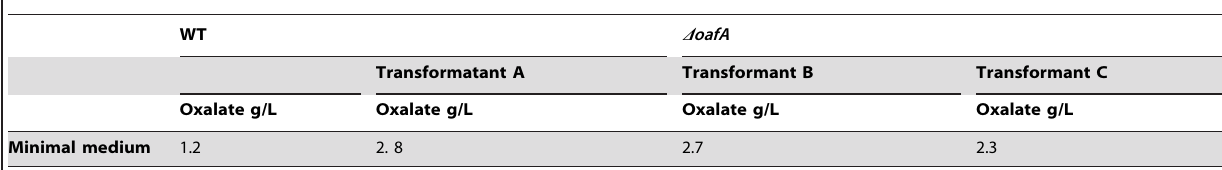
Table 2. Oxalate concentration in static cultures pH 6.0.